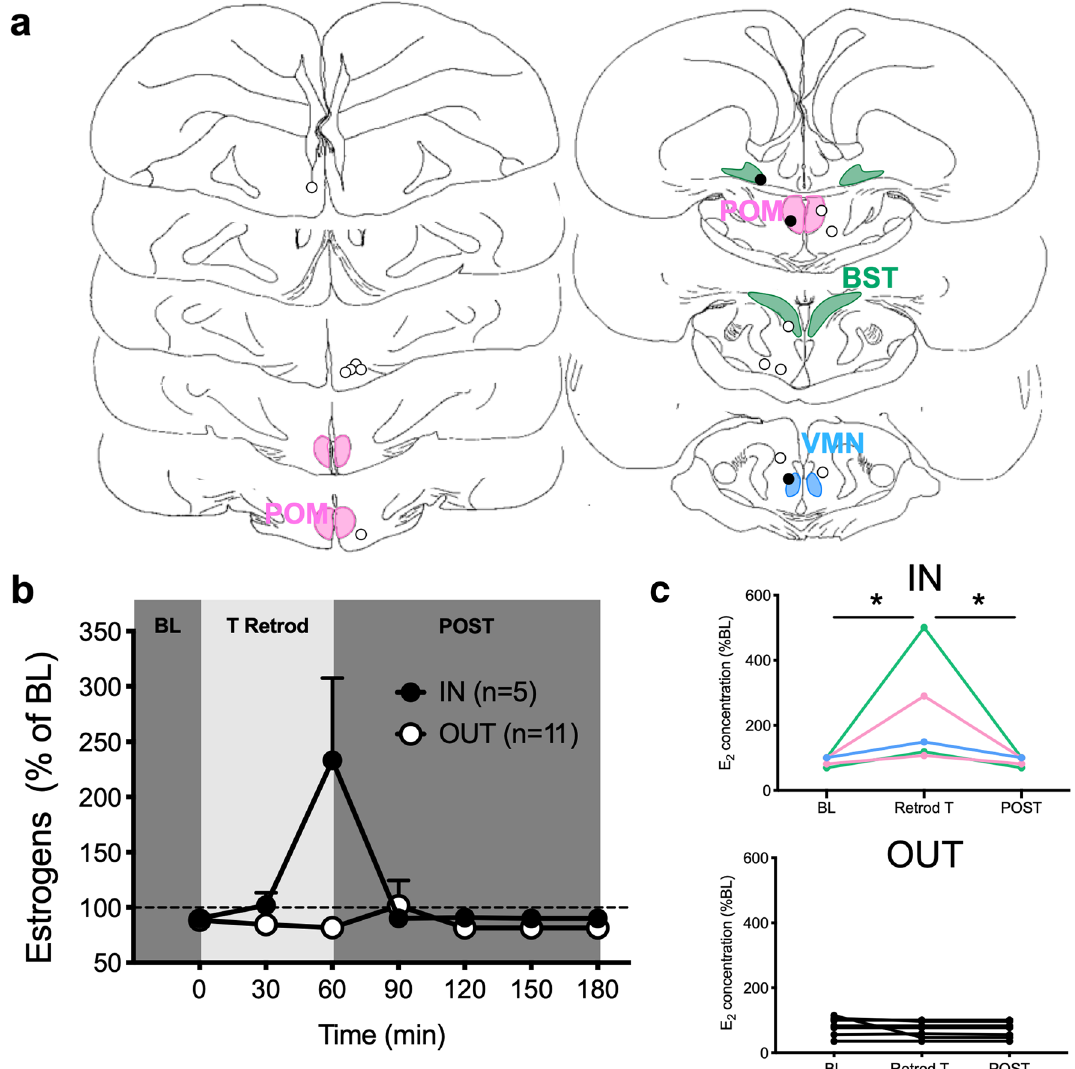
Figure 2. Effect of testosterone retrodialysis on the changes in estrogen concentrations in the dialysate expressed as a percentage of the baseline. ( a ) Schematic representation of coronal sections of the quail brain showing the location of the dialysis probes: IN probes are either within or touching the colored zones representing brain regions expressing aromatase. See legend of Fig. 1 for the definition of different brain areas. Black and open circles respectively represent birds in which estrogen concentrations did or did not increase above 150% of the BL during the retrodialysis of T. ( b ) Mean changes in time of estrogen concentration relative to the mean concentration measured in the 3 samples composing the baseline period. BL: baseline (last point of a 90 min baseline period), T Retrod: Testosterone retrodialysis, POST: Period after the end of testosterone retrodialysis. Only males with a probe in a brain region expressing aromatase exhibited a significant rise in estrogens peaking at the end of the retrodialysis period and then immediately returning to BL (Friedman ANOVAs: IN, χ 2 n=5 = 21.82, p = 0.0013; OUT, χ 2 n=11 = 6.667, p = 0.3528; no post hoc comparison reached significance). ( c ) Individual percent changes in E 2 concentration relative to BL at the end of the three sampling periods for IN and OUT birds (for IN birds the line color refers to the color of areas in panel A; Friedman ANOVAs: IN, χ 2 n=5 = 10.00, p = 0.0123; OUT: χ 2 n=11 = 2.00, p = 0.7778; post hoc *p < 0.05). The baseline amounts of estrogens per sample in this experiment ranged between 0.041 and 0.395 pg per sample (10 µl; Mean ± S.E.M. = 0.099 ± 0.018, n = 16). Panel A is composed of home made drawings onto which probe positions were reported using Graphic for Mac (https:// graph ic. com/ mac/), other panels were created with Graph Pad Prism 8 (https:// www. graph pad. com/ scien tific- softw are/ prism/). All panels were assembled in